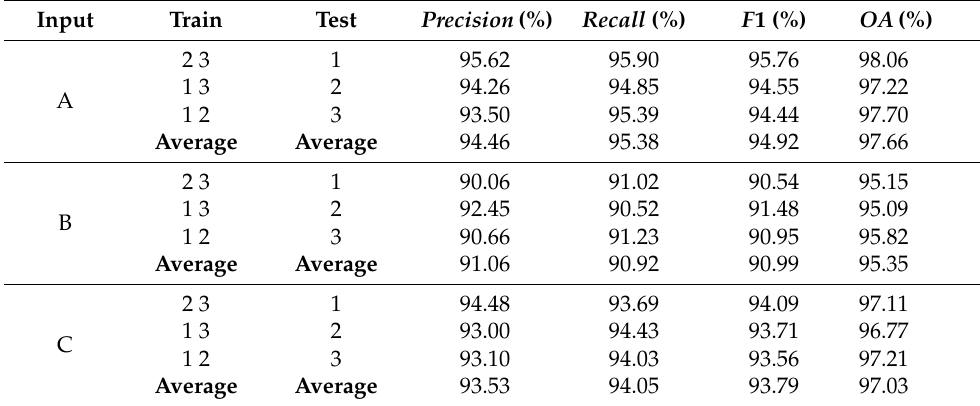
Figure 15. Data division used in k-fold validation. Table 11. 3-fold validation results by using various training-validation